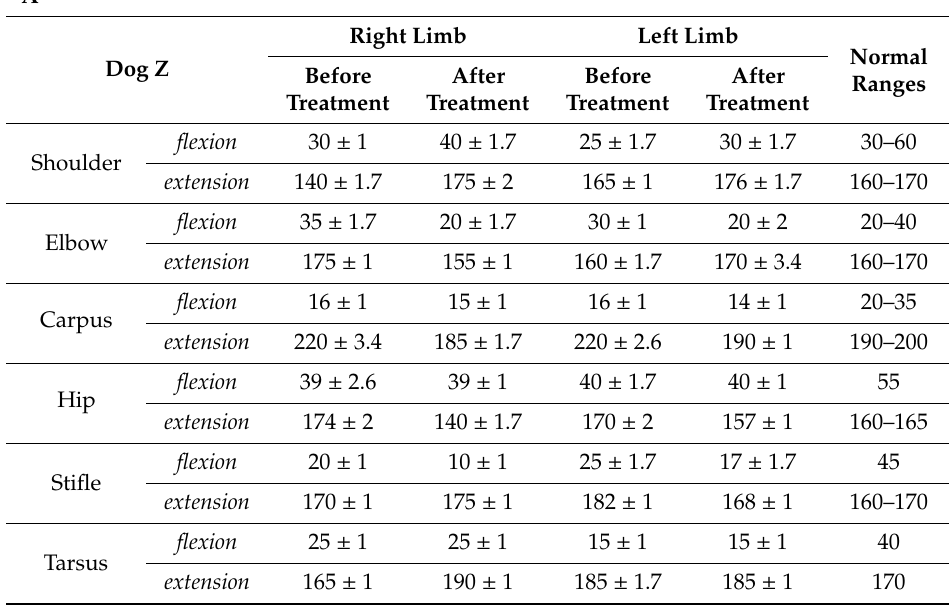
Table 1. Goniometric measurements of mobility. ( A , B , C ) Measurements of flexion and extension according to the anatomical coordinates for shoulder, elbow, carpus, hip, stifle were performed in Dogs Z, B and M